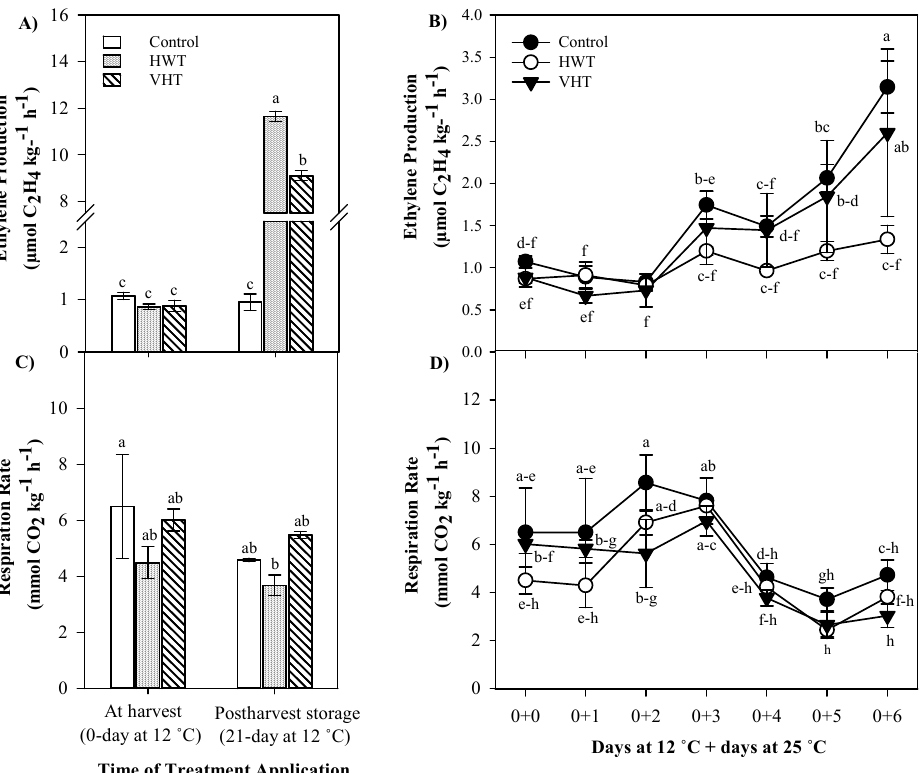
Figure 1. Effect of the heat treatments applied at harvest and post-harvest storage on the ethylene production ( A , B ) and respiration rate ( C , D ) of mango fruits. Error bars show standard errors of the means ( n = 3). Different letters indicate significant difference according to LSD at p ≤ 0.05.